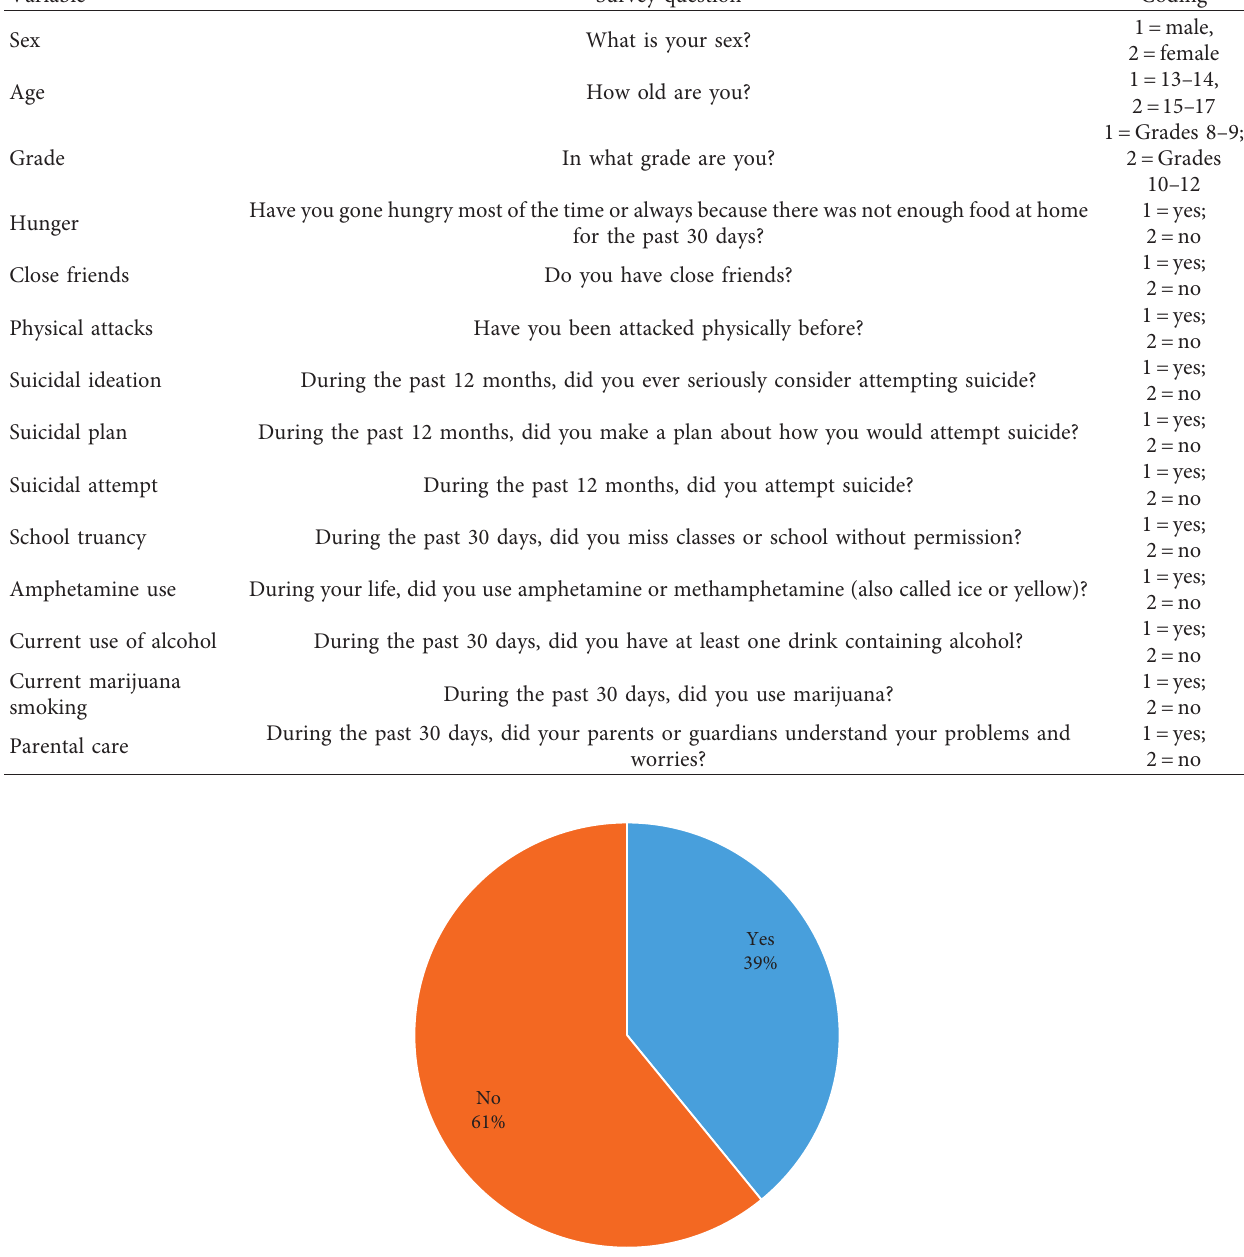
Figure 1: Serious injuries among adolescents attending pretertiary schools in